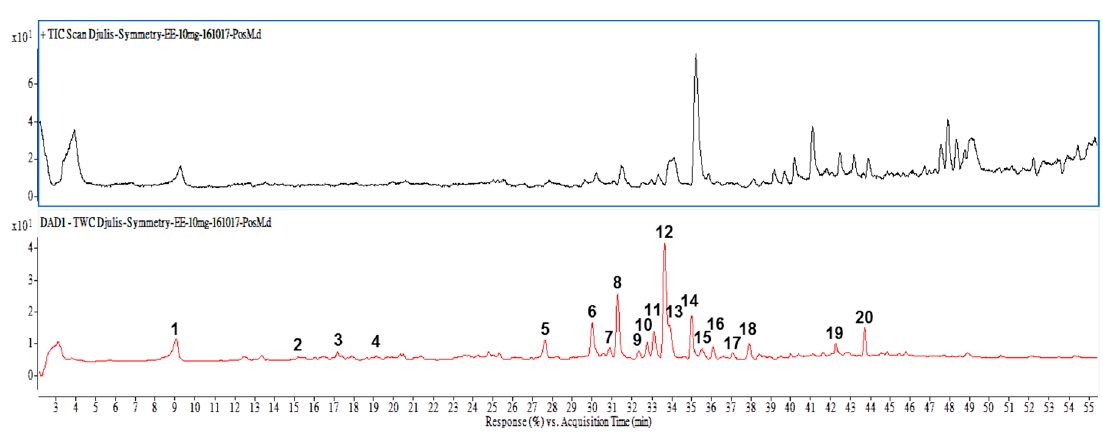
Figure 3. Total ion chromatograms of LC/MS analysis in positive electrospray ionization ( top panel ) and HPLC-photodiode array detection chromatograms ( lower panel ) at full scan of 210–600 nm from aqueous ethanol extract of Djulis. Peak numbers are referred to Table 1.